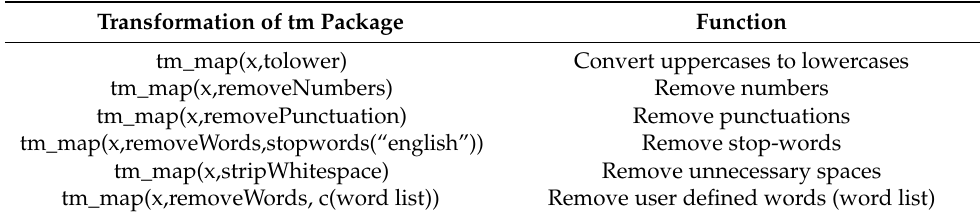
Table 1. Transformation functions of tm package for text mining.